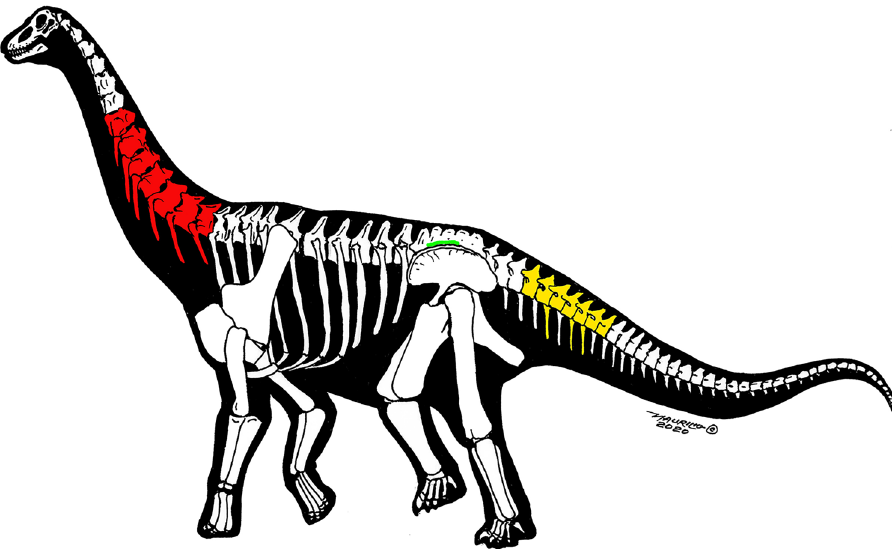
Figure 2. All specimens described in this paper shown in one outline of a generic titanosaur: preserved cervical elements of Silutitan sinensis gen. et sp. nov. (IVPP V27874) (red), preserved caudal elements of Hamititan xinjiangensis gen. et sp. nov. (HM V22) (yellow) and the preserved sacral elements (IVPP V27875) (green). Image credit: Maurílio